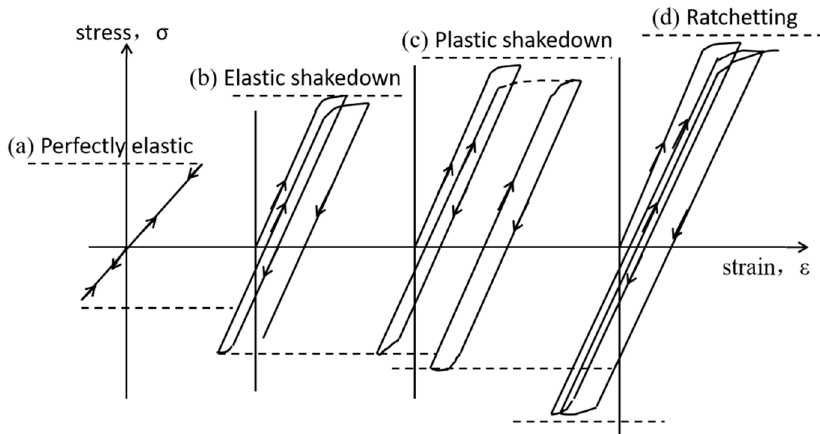
Figure 13. The schematic diagram of the stress and strain of materials during rolling operation [25].